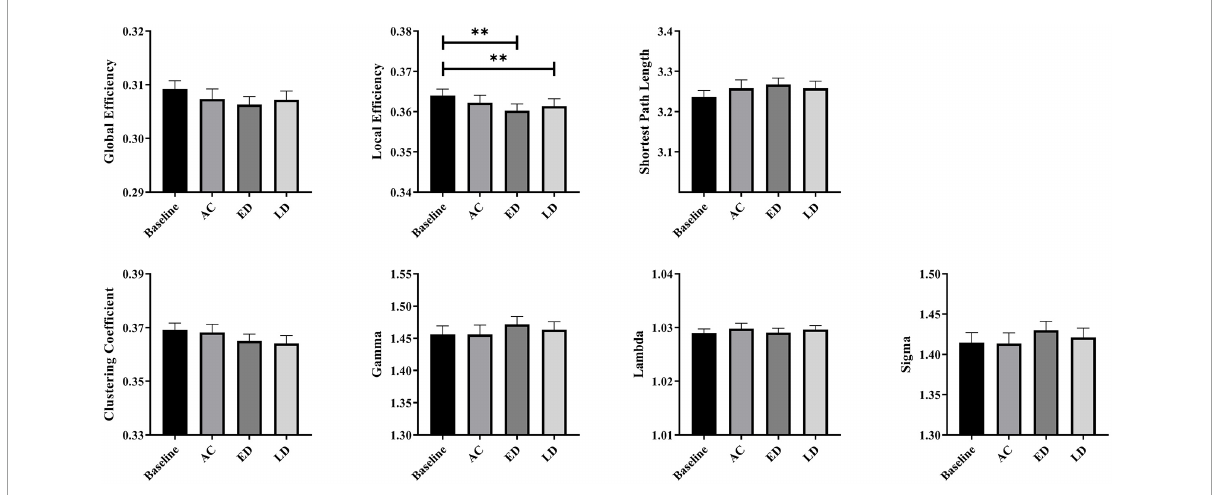
FIGURE4 The regions with significantly different nodal efficiency and degree centrality across four stages by repeated measures ANOVA and for post-hoc pairwise comparisons between the baseline and three following post-RT stages (post-RT-AC, post-RT-ED, and post-RT-LD). The full names of the AAL atlas regions with corresponding abbreviations are listed in Supplementary Table 1 . L, left hemisphere; R, right hemisphere; AC, post-RT-AC; ED, post-RT-ED; LD, post-RT-LD; Repeated ANOVA, one-way repeated measures analysis of variance.